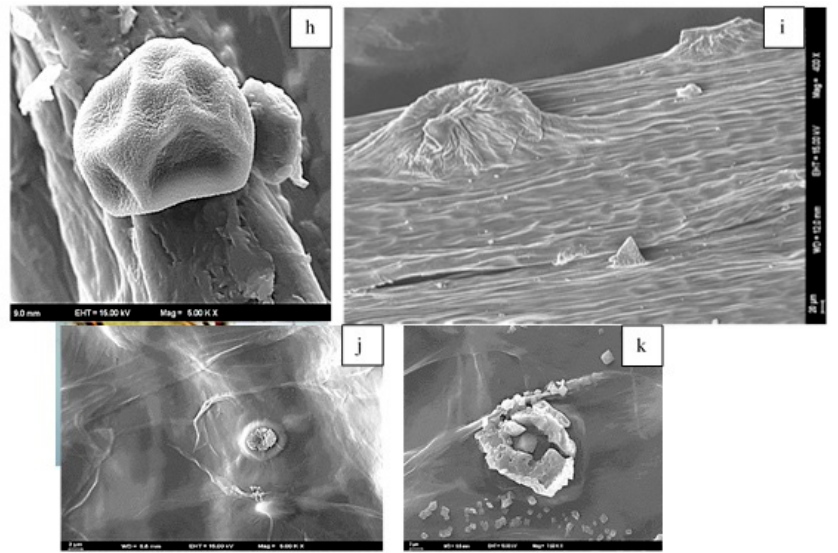
Figure 9. ( a ) Capitate trichomes on the leaf by SEM, ( b, c, d ) capitate trichomes on the pedicel by SEM, ( e, f, g ) capitate trichomes on the stem by SEM, ( h, i, j, k ) extrafloral nectaries, the secretory ducts and excretion secretory system on the fruit by